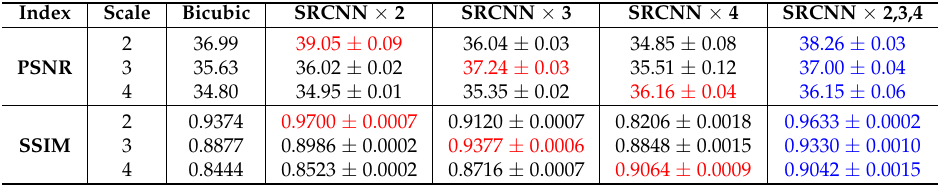
Table 7. Cross-scale experiments of SRCNN trained and tested on BUAA-SID 1.0 (mean deviation). The red font indicates the best performance, while the blue font indicates the second